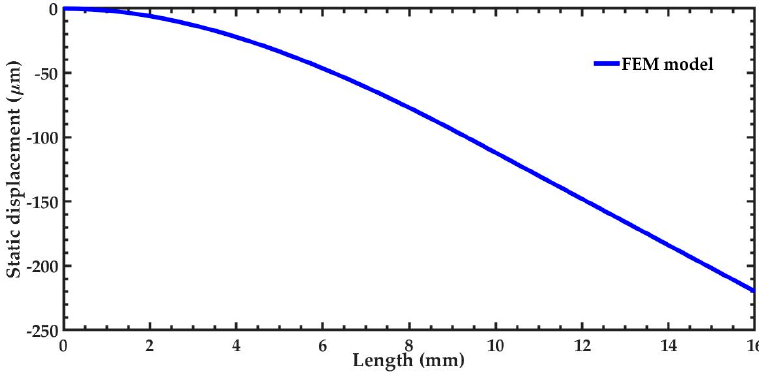
Figure 12. Static displacement of the pVEH microdevice as a function of its length.